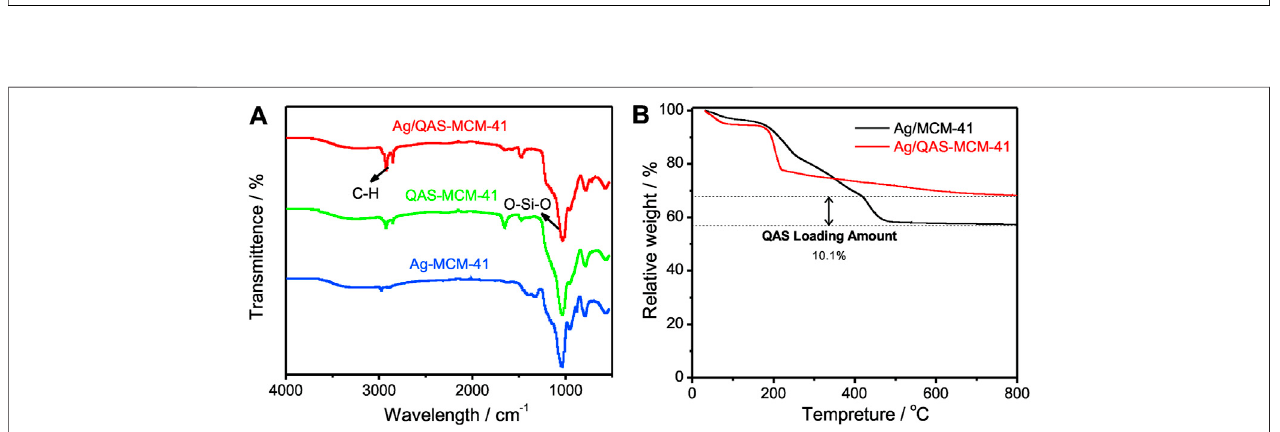
FIGURE 1 | (A) Schematic illustration for the synthesis of Ag/QAS co-decorated MSNs. (B) TEM image of Ag/QAS-MSNs. (C) HRTEM images of Ag/QAS-MSNs. (D) XRD patterns of Ag/QAS-MSNs.